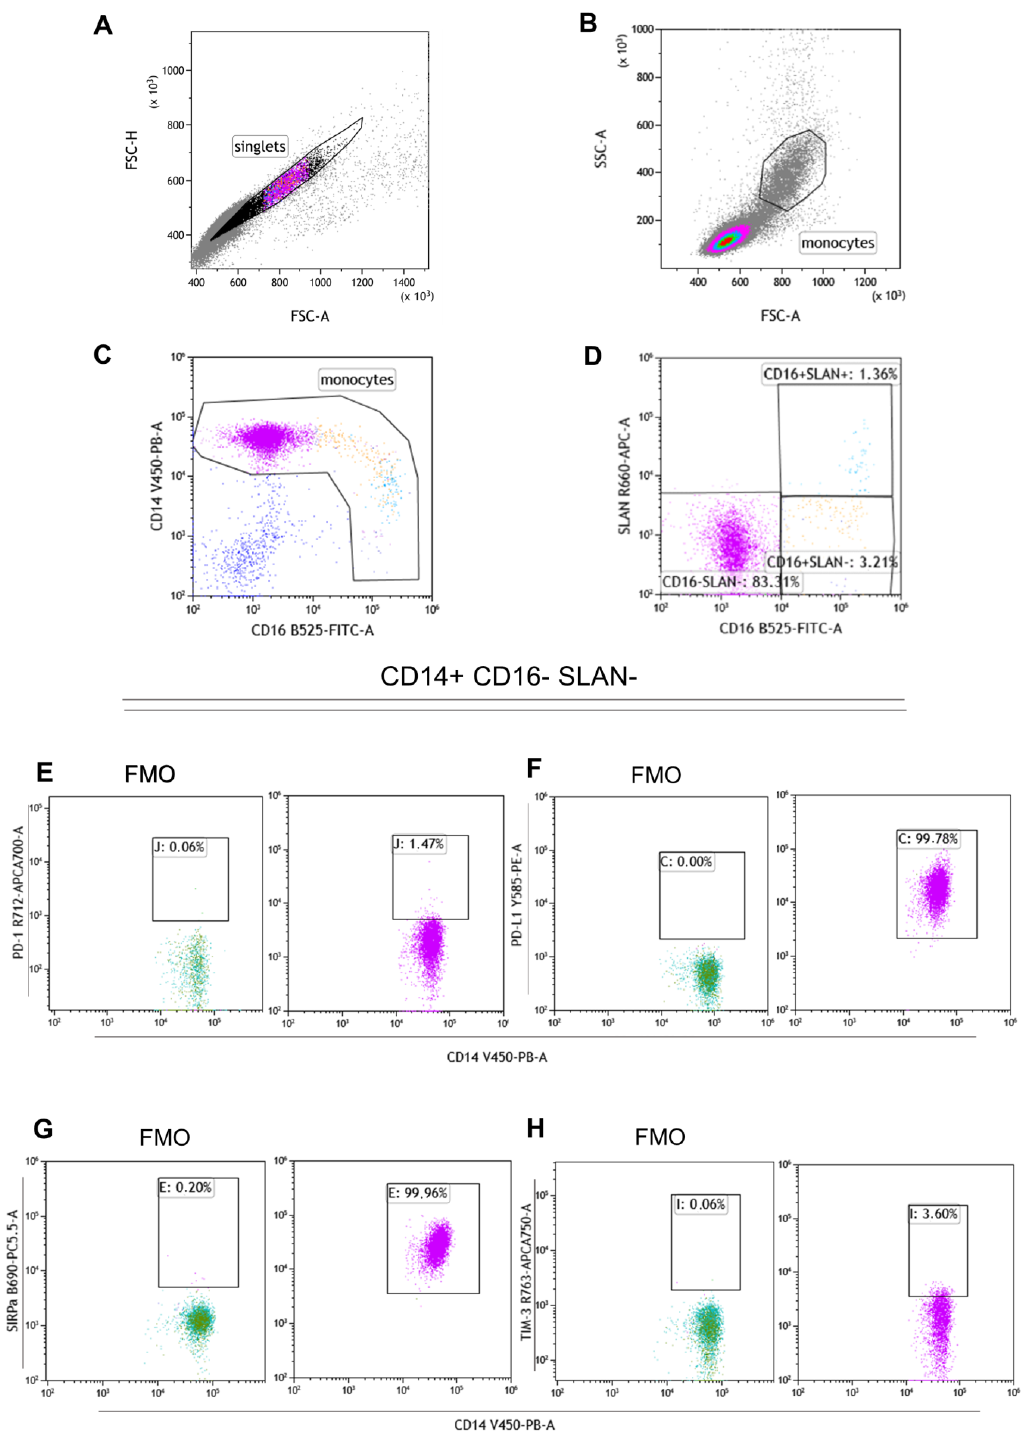
Figure 8. The gating strategy for monocyte subpopulations is demonstrated in ( A – D ) dot plots. Doublets elimination and setting up gate covering on singles population is presented in panel ( A ). Therefore, FSC-A vs. SSC-A gating was used for monocyte selection ( B ). For a more accurate determination of the monocyte population, assessment of CD14 V450 vs. CD16 FITC was used ( C ). The gating from the panel ( D ) CD16 FITC vs. SLAN APC was used to identify classical (CD14 + CD16 − SLAN − ), intermediate (CD14 dim CD16 + SLAN − ) and non-classical (CD14 low/ − CD16 + SLAN + ) monocytes. The assessment of immune checkpoint molecules based on fluorescence-minus-one (FMO) control for classical monocytes (CD14 + CD16 − SLAN − ) is shown in dot plots ( E – H